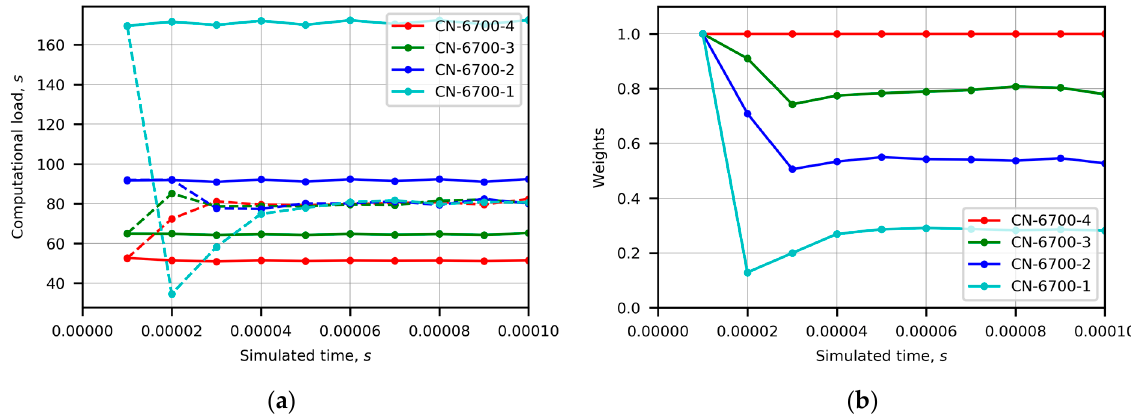
Figure 2. Time evolution of the computational load ( a ) and weights ( b ) in Case 1.